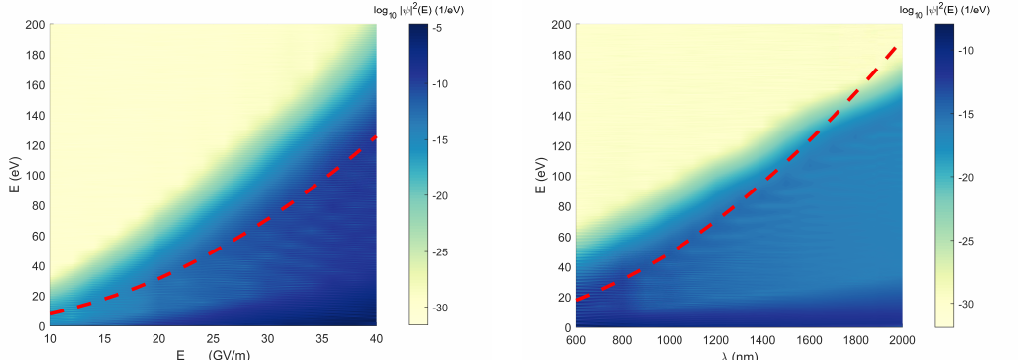
Figure 9. Electron spectra for varying peak field and wavelength. The semi-classical cutoff is shown as a dashed red line. Variable peak field at 800 nm ( Left ) shows a good trend of following the classical 10 U p ∝ E 2 max cutoff for electron rescatter spectra. Spectra at variable wavelength with peak field of 20 GV/m ( Right ) also indicates a good general trend to the classical cutoff of 10 U p ∝ λ 2 . This spectral map begins to deviate from the prediction beyond 1600 nm.